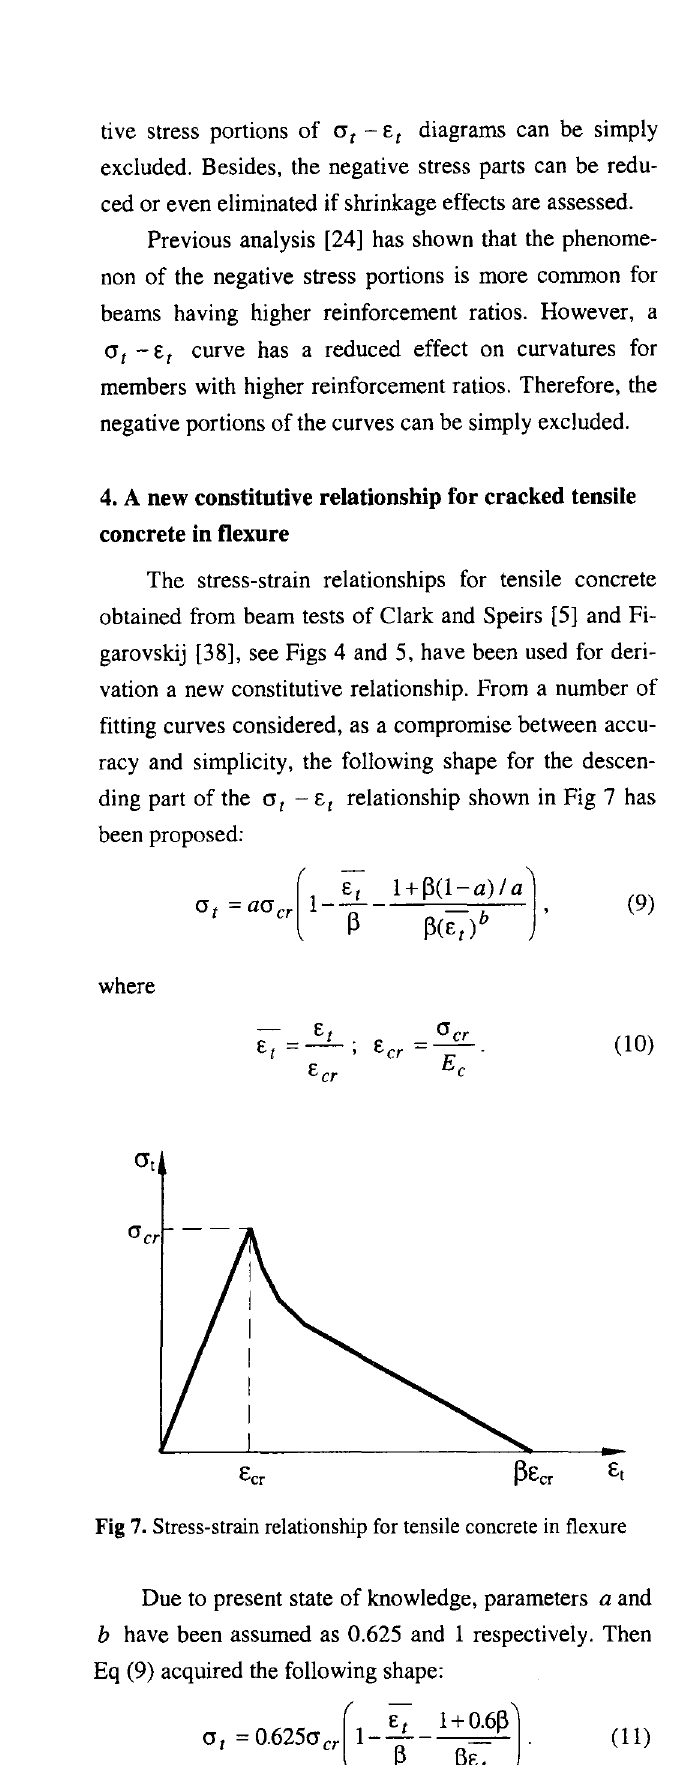
Fig 7. Stress-strain relationship for tensile concrete in flexure Due to present state of knowledge, parameters a and b have been assumed as 0.625 and 1 respectively.